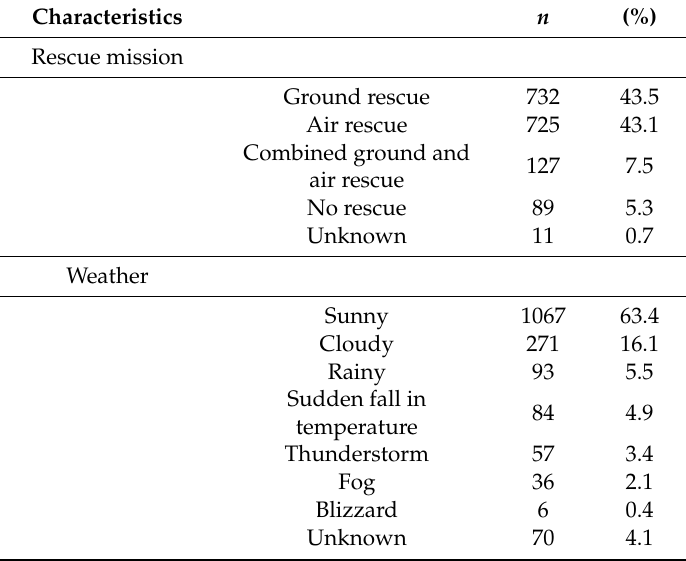
Table 1. Characteristics of via ferrata accidents in Austria from 1 November 2008 to 31 October 2018. Listed according to